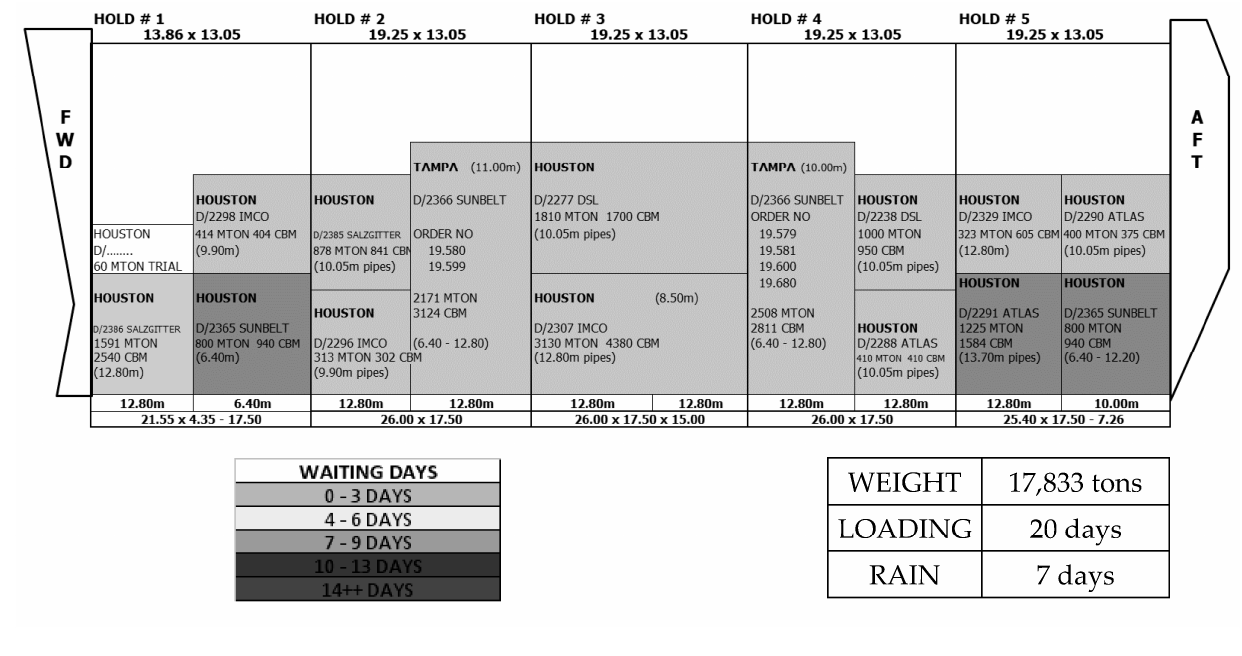
Figure 4. Completion of production in days for different types of pipes when ( a ) Vessel 1 arrives, ( b ) Vessel 2 arrives, and ( c ) Vessel 3 arrives.